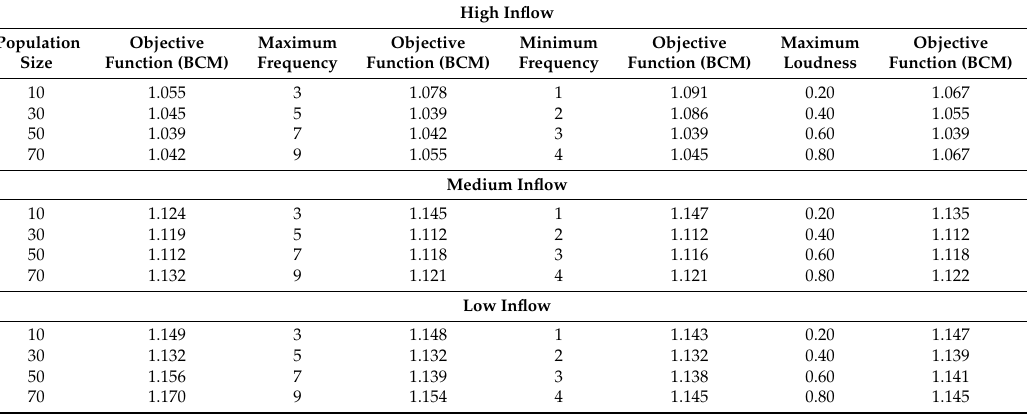
Table 3. Sensitivity analysis for